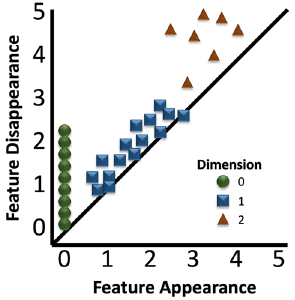
Fig. 3 Persistence diagram that tracks features in the 0th, 1st, and 2nd homology groups. This persistence diagram shows where the 0th, 1st, and 2nd Betti numbers appear ( X -axis) and disappear ( Y -axis) throughout the filtration of the